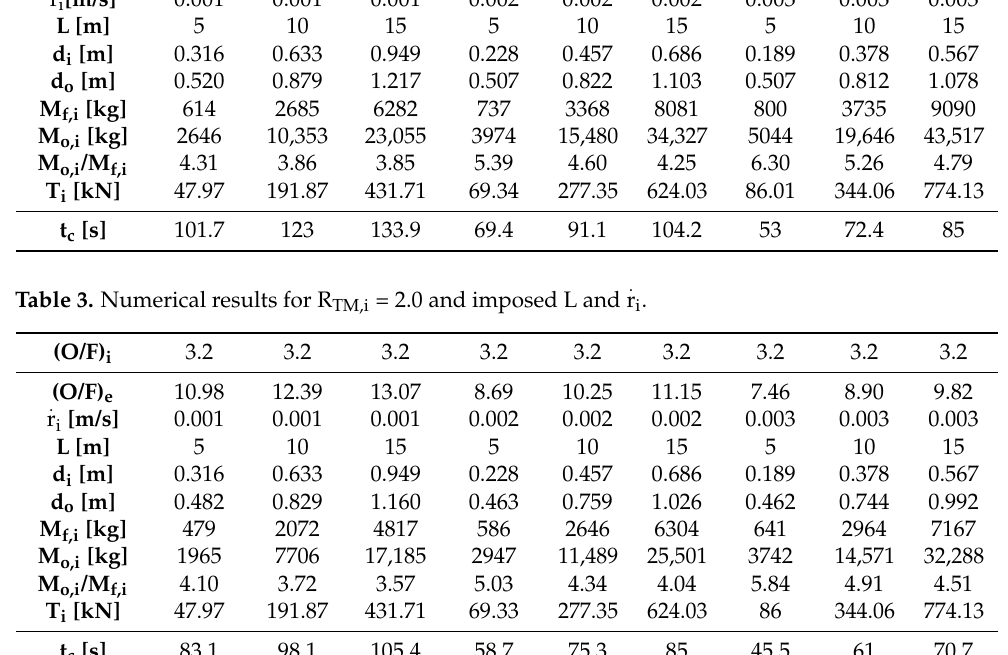
Table 2. Numerical results for R TM,i = 1.5 and imposed L and